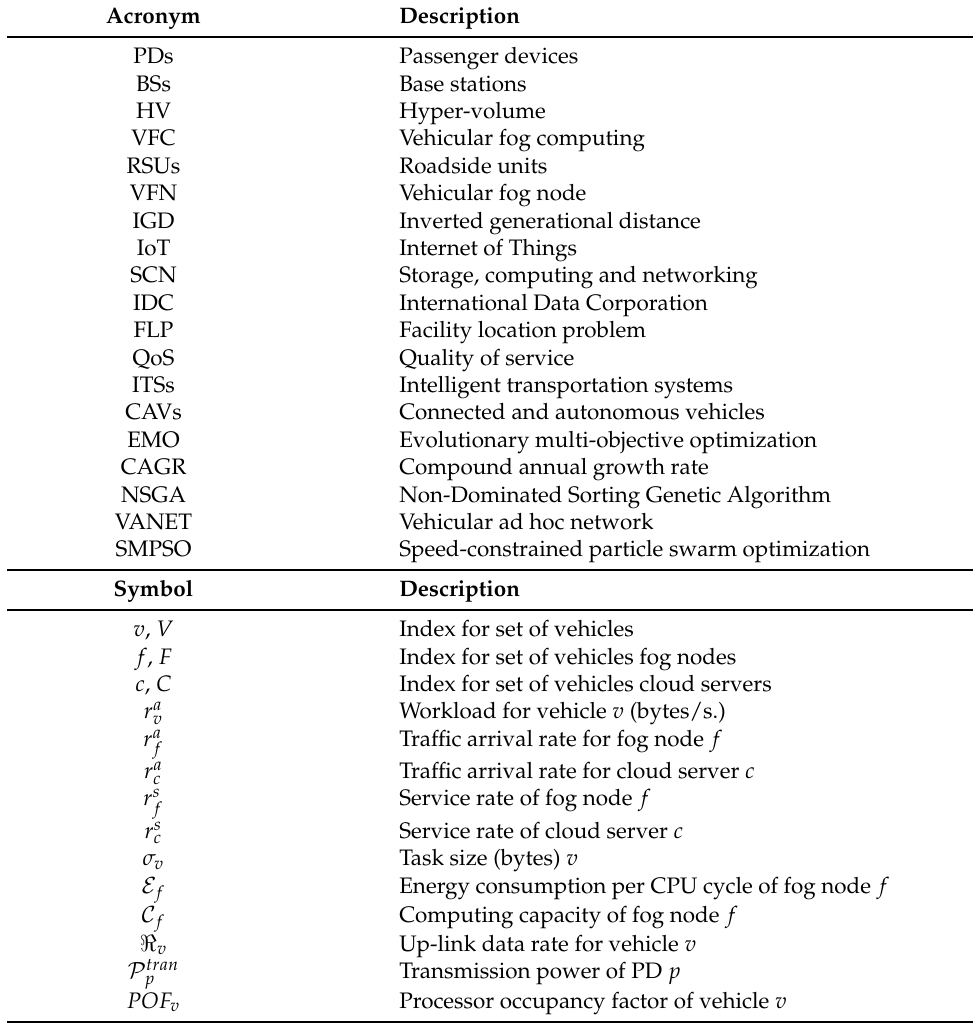
Table 2. Acronyms and symbols used in this